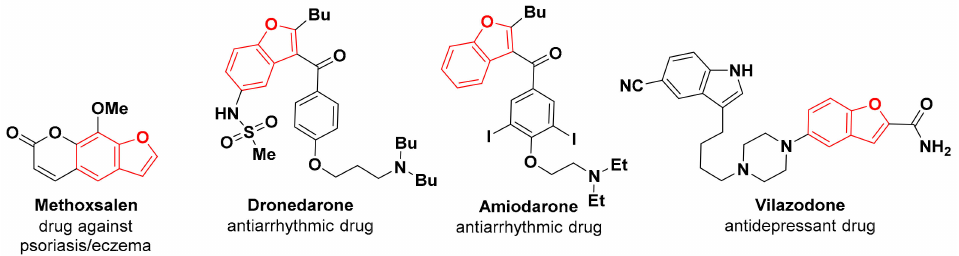
Figure 1. Examples of drugs containing the benzofuran sca ff